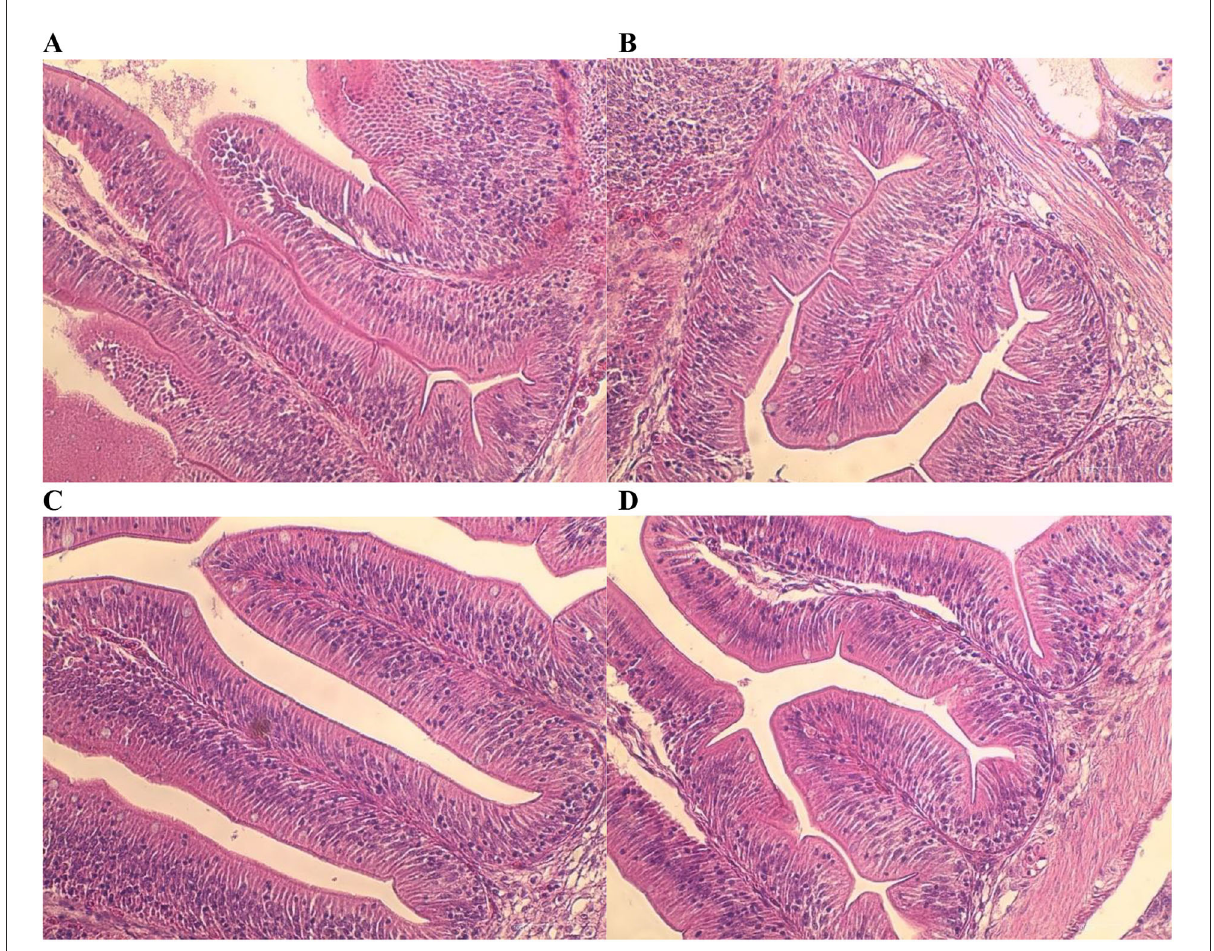
FIGURE6 Intestinal morphology of seawater-tolerant tilapia fed with different levels of T. weissflogii paste. (A) D0, (B) D1, (C) D2, (D) D3. Scale bar = 100 µ